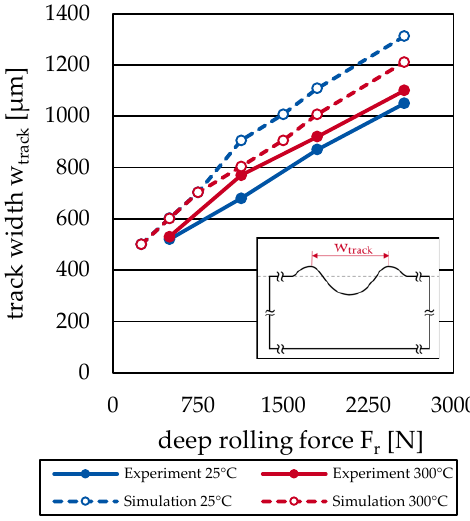
Figure 11. Comparison of simulated and measured track widths w track for 25 °C and 300 °C. Table 4. Relative deviations between simulated and measured track widths.